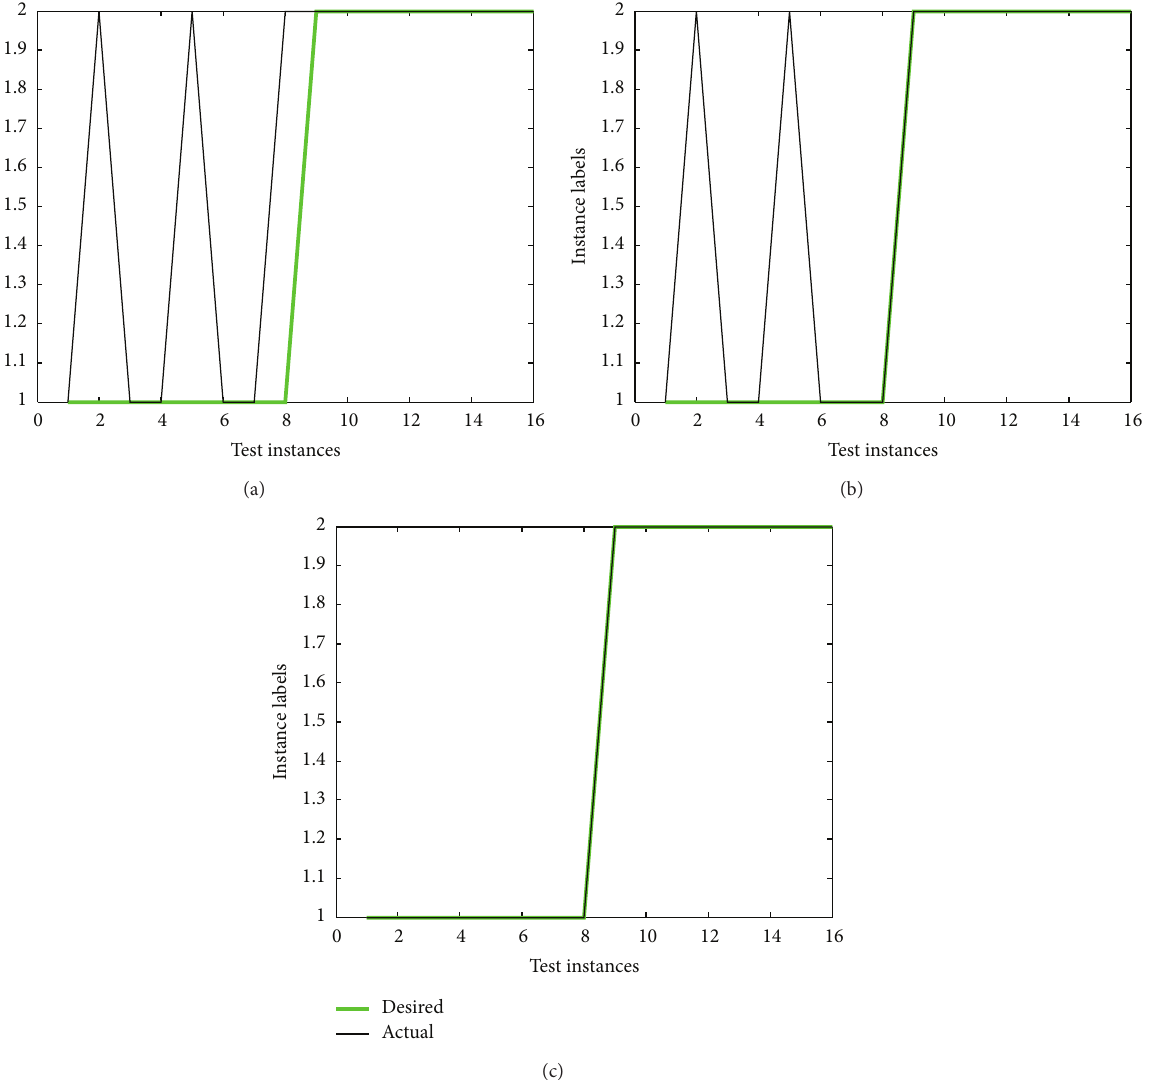
Figure 5: (a) Testing results after 100 epochs using Euclidean RBF kernel; misclassifications exist. (b) Testing results after 150 epochs using